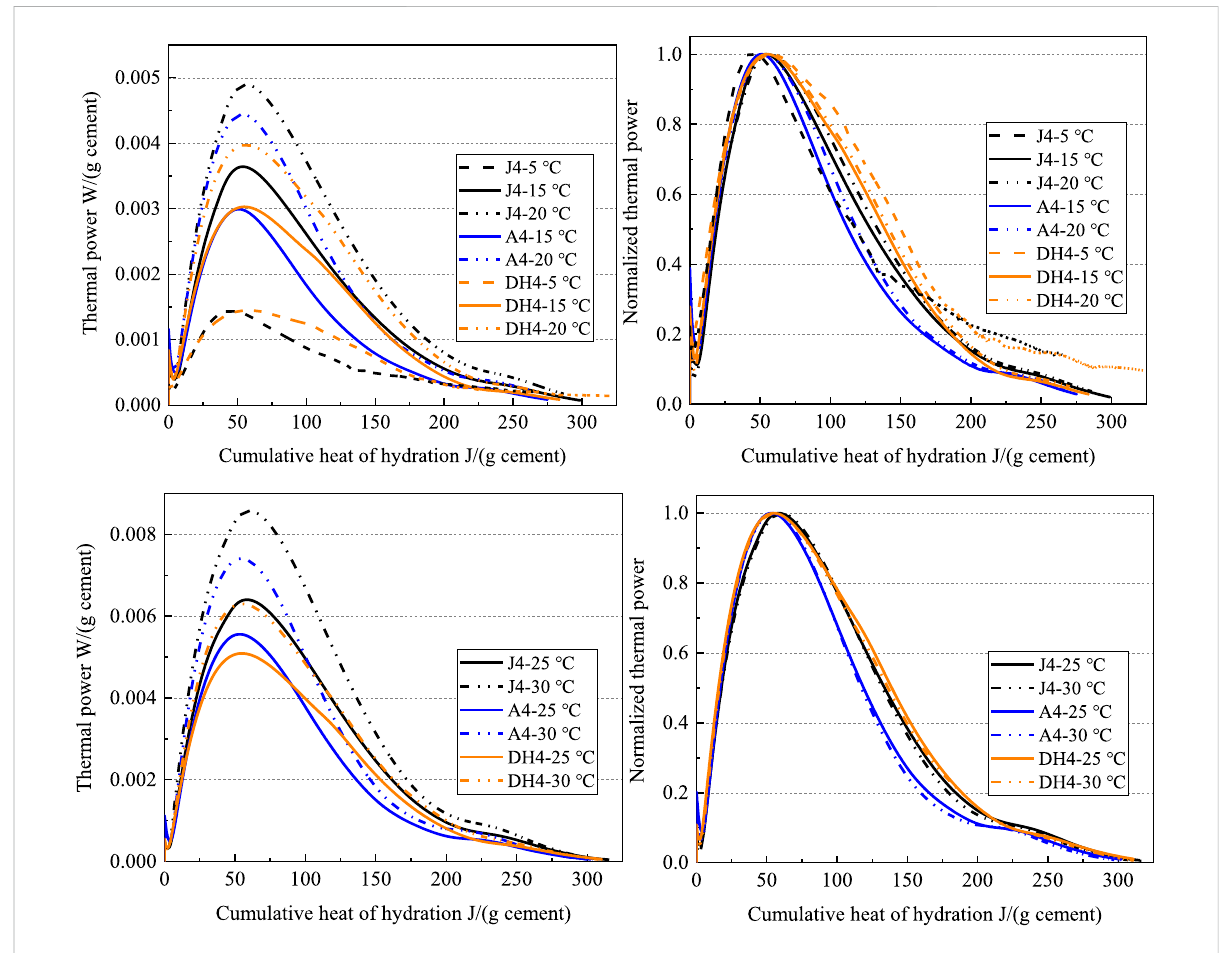
FIGURE 7 Thermal power vs. cumulative hydration heat before (left) and after (right) normalized different Class G